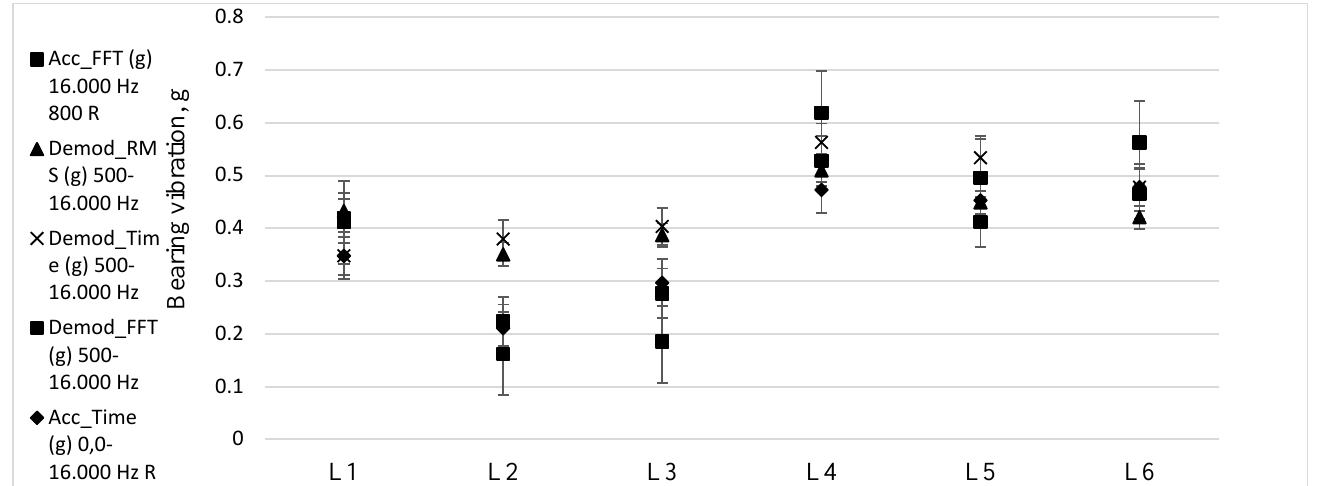
Figure 8. Bearing vibration acceleration at 3050 min – 1 speed. L1, L2, L3; accelerometer placed directly on a bearing seat. L4, L5, L6; accelerometer placed on a manufactured bracket.